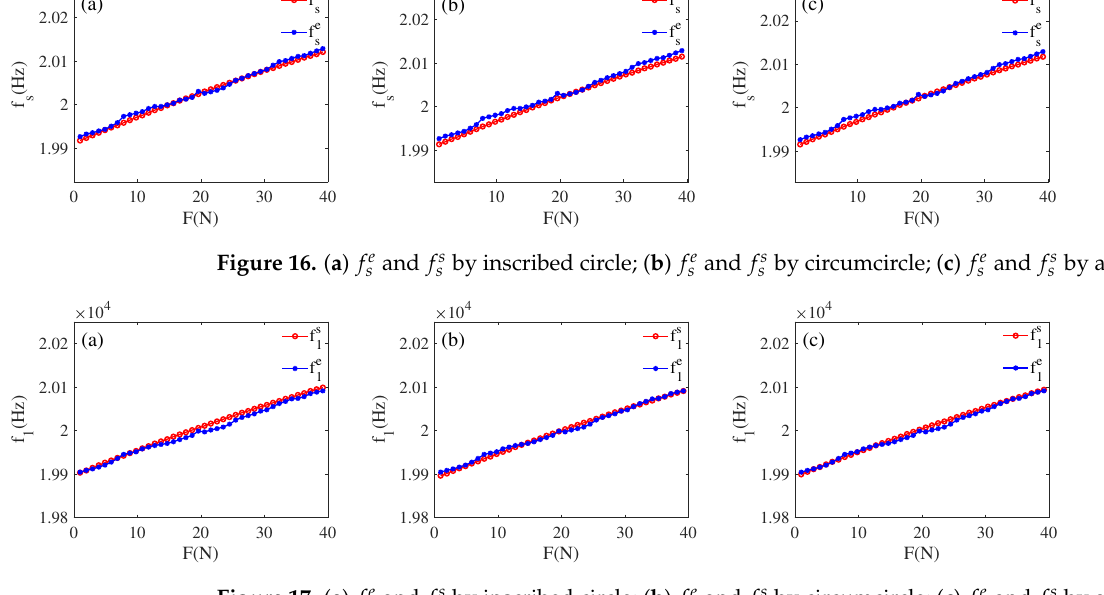
and f s by inscribed circle; ( b ) f e 1 1